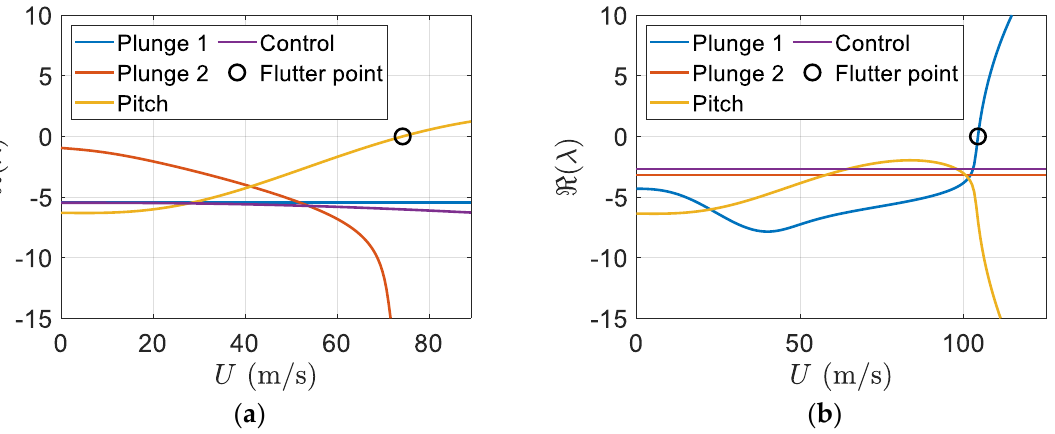
Figure 17. Eigenvalues real part versus airspeed: ( a ) smart blade with plunge piezopatches; ( b ) smart blade with plunge and pitch piezopatches.